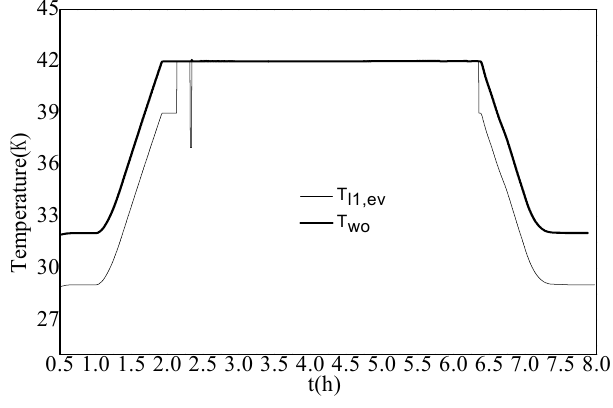
Figure 12. Variation in water temperatures.